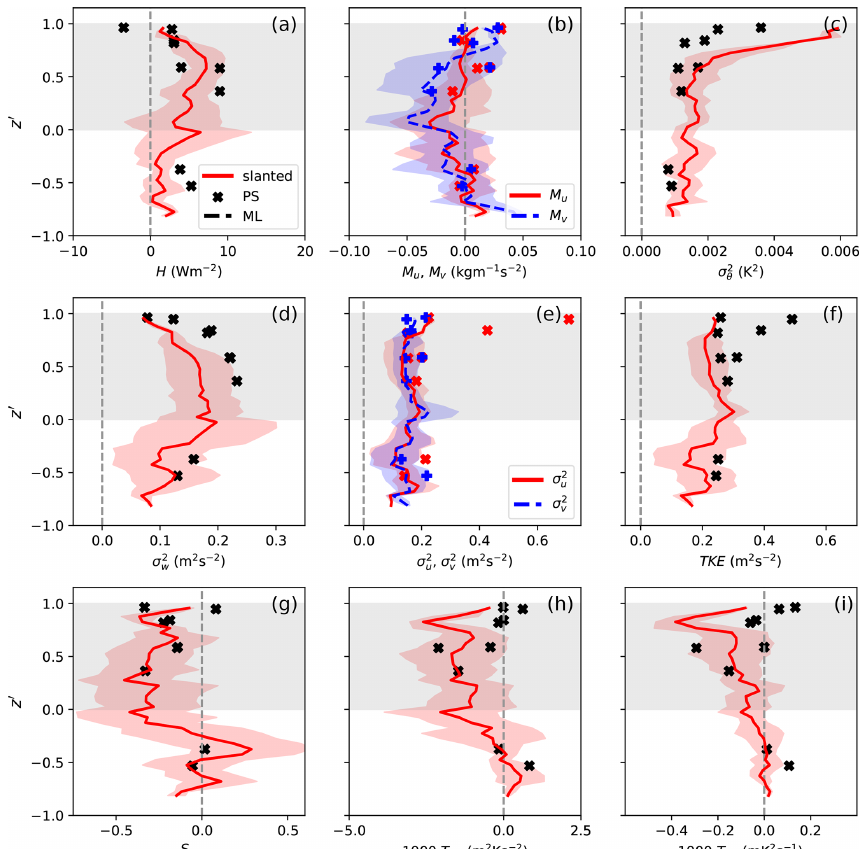
Figure 4. Vertical profiles of turbulence statistics obtained from horizontal legs over PS (black crosses) and slanted profiles on 5 June 2017. Red lines represent mean values based on four slanted profiles, while red shading indicates ± 1 standard deviation. The cloud layer as observed over PS is shown with grey